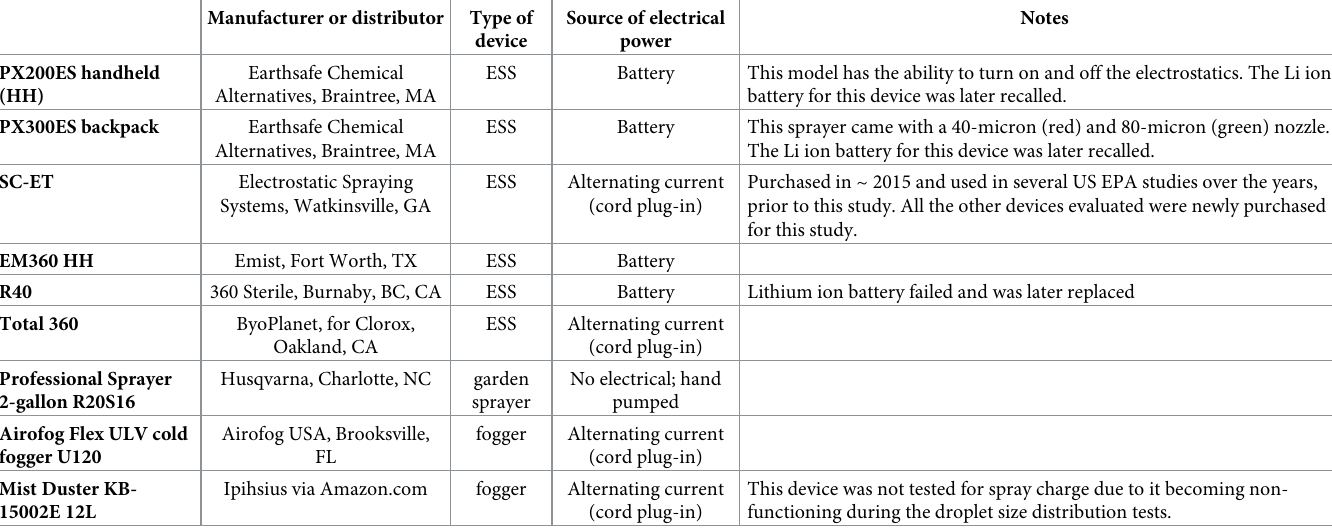
Table 1. Summary of spray and fog devices evaluated in the